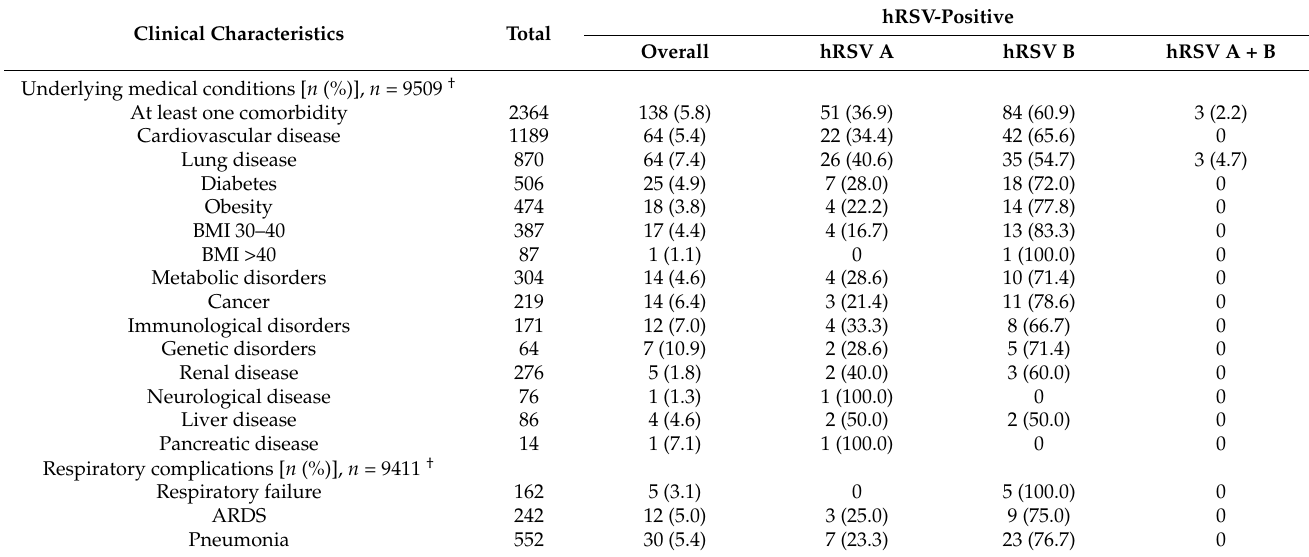
ARDS = Acute Respiratory Distress Syndrome. † Percentages are not mutually exclusive.